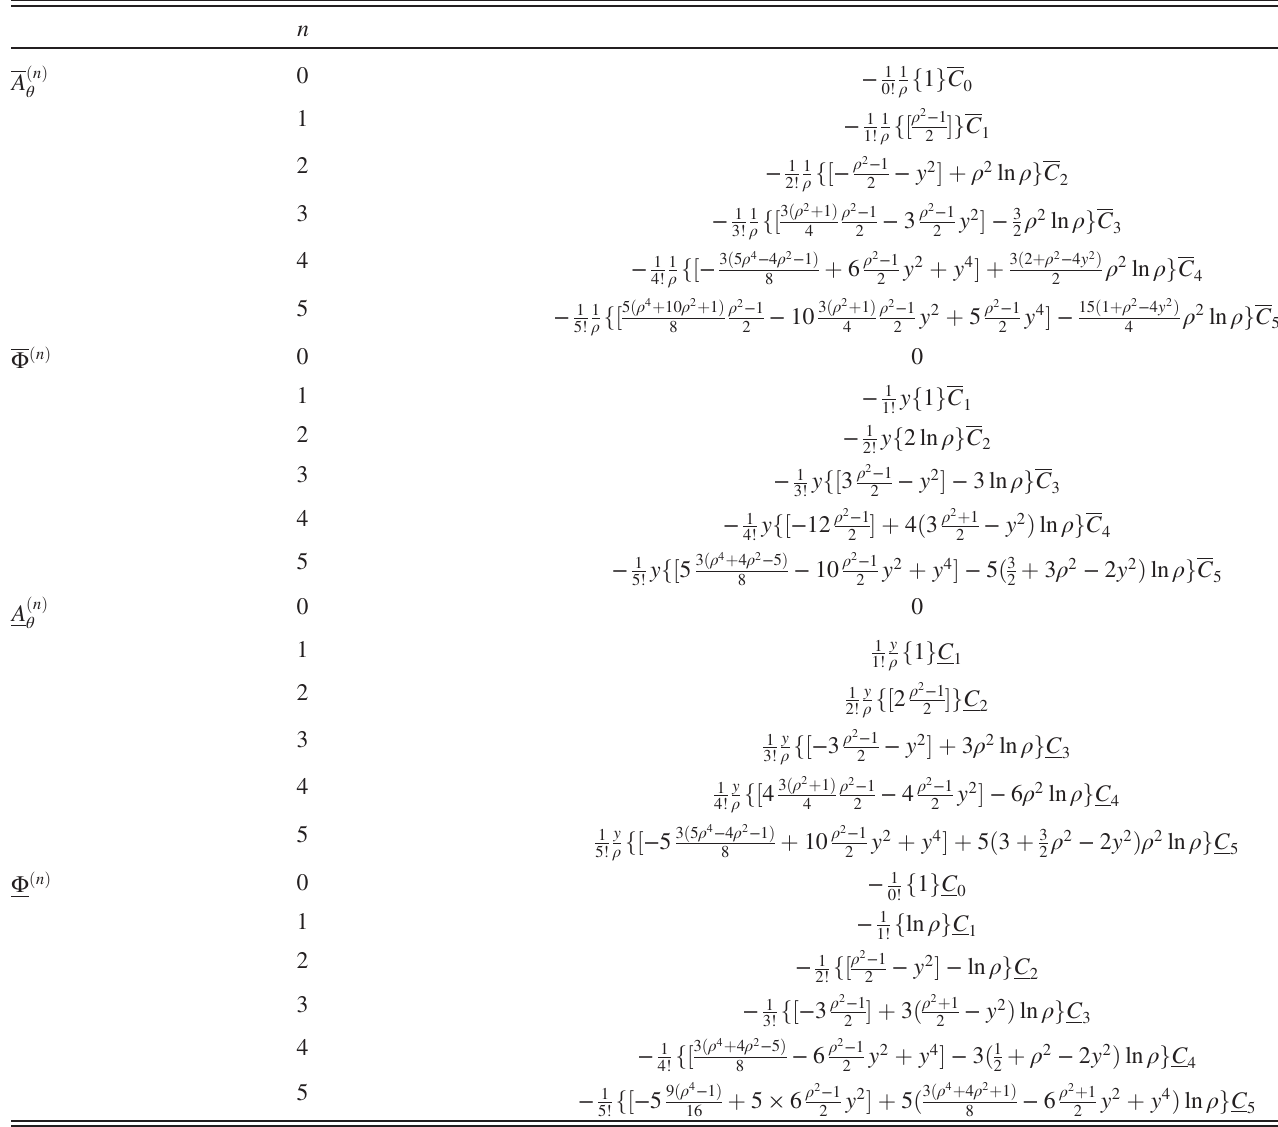
TABLE XI. Azimuthal component of the vector potential and scalar potential for pure normal and skew S-multipoles.